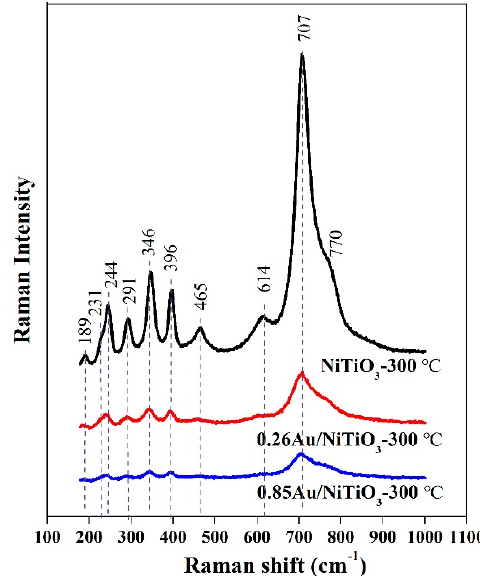
Figure 4. Raman spectra of the NiTiO 3 and Au/NiTiO 3 samples pre-treated in H 2 at 300 °C.